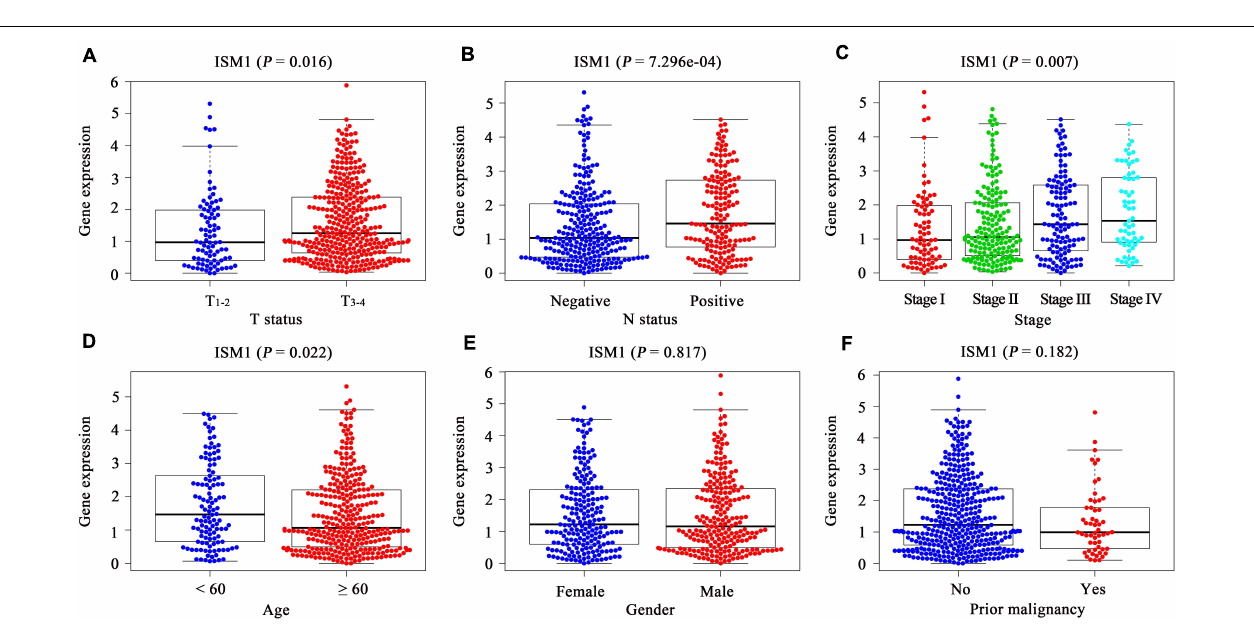
FIGURE 2 | Correlation between clinicopathological characteristics and ISM1 in CRC. (A–F) ISM1 expression changes in patients with T 3 – 4 (vs. T 1 – 2 ), lymph node involvement, advanced stages, age < 60 (vs. ≥ 60), and prior malignancy (yes vs. no). P < 0.05 is statistically significant.